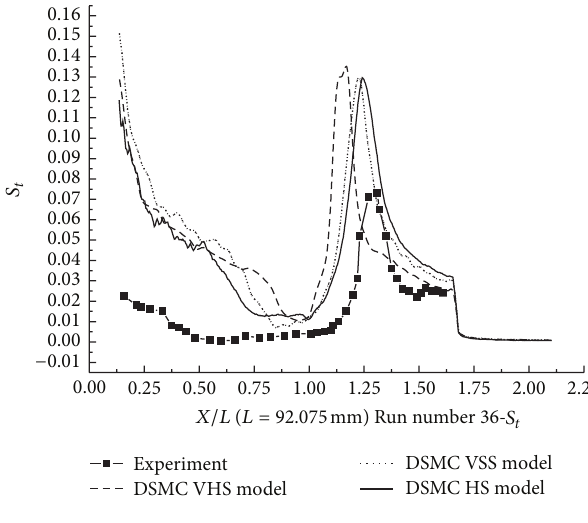
Figure 16: DSMC simulation of Run number 33 ( 𝑆 𝑡 ).